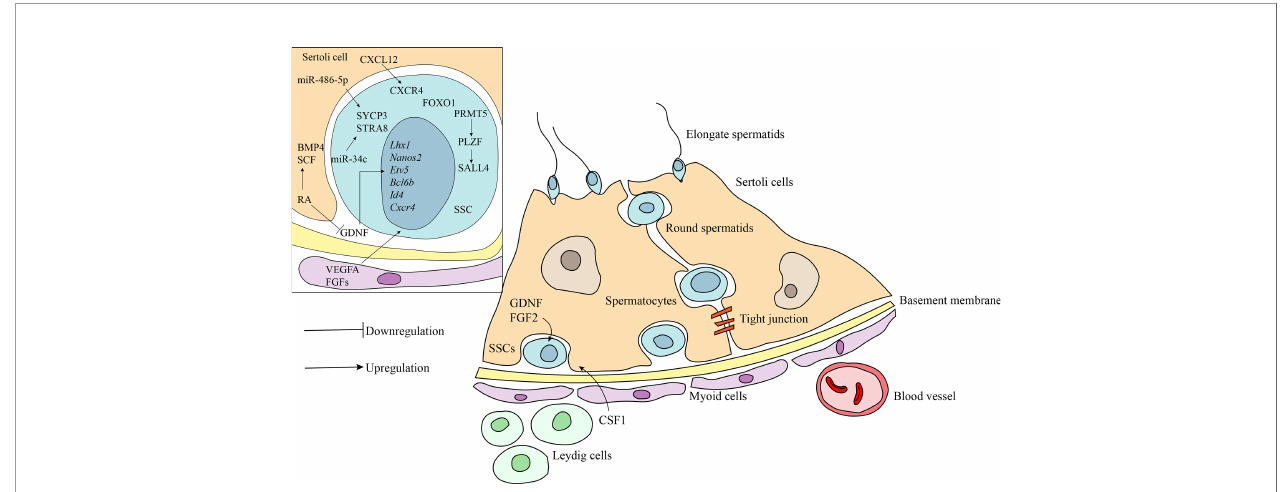
FIGURE 1 | Schematic diagram of the niche of SSCs and the regulatory factors involved in maintaining the stemness and self-renewal of SSCs. Undifferentiated SSCs are localized at the basement membrane. Germ cells maintain the close contact with the Sertoli cells inside the seminiferous epithelium. Peritubular myoid cells surround the seminiferous tubules to form testicular cords. The interstitial compartment consists of many somatic cell types including Leydig cells, mesenchymal cells and immune cells. Bioactive factors in the niche play crucial role in self-renewal and differentiation of SSCs. CXCL12/CXCR4, FGFs, and VEGFA act in synergy with GDNF to maintain SSCs. Retinoic acid (RA) induces the differentiation of SSCs by downregulation, at least in part, of GDNF expression and activation of SCF and BMP4. Transcription factors, PLZF and FOXO1, are involved in regulating SSCs maintenance and spermatogenesis by acting on a subset of downstream target gene. MicroRNAs, including miR-1908-3p, miR-112-5p and miR-31-5p, also act as critical regulators in